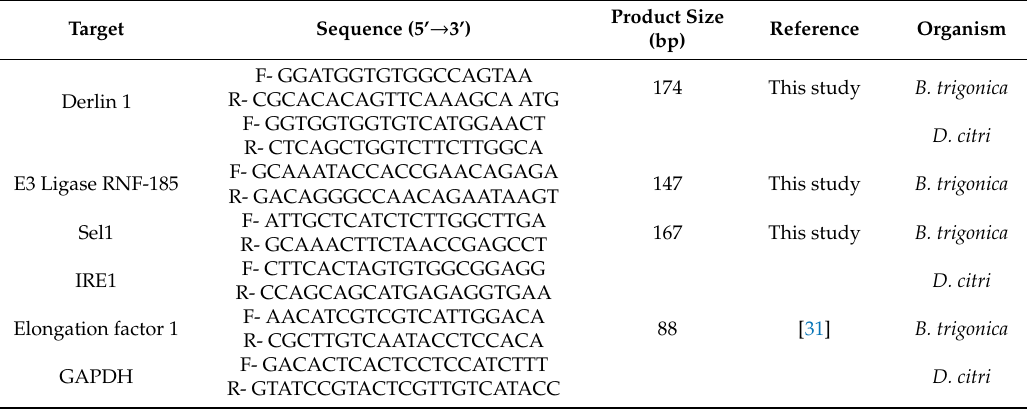
Table 1. Primers used for relative quantification of selected DEGs by